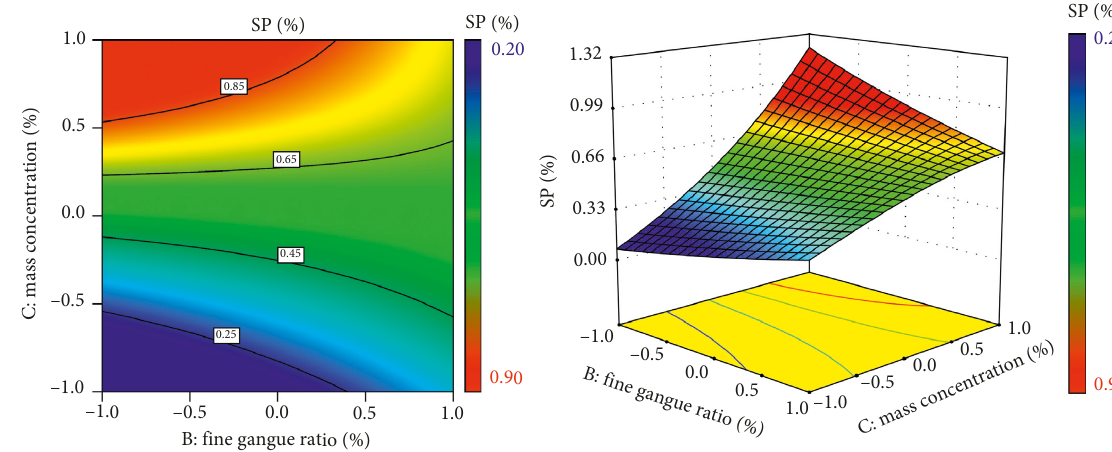
Figure 4: Influence of B, C, and their interaction on